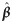
Latitude and longitude coefficients in the logit scale (β^ ±SD, 95% BCI) on logit occupancy (logit ψ^) of each bird species in the regional bird monitoring program in Argentina, 2003–2012.(a) Raptors; (b) ground omnivores and herbivores; (c) ground granivores; (d) other granivores; (e) insectivores mostly associated with folliage; (f) other insectivores. For details of species names and guilds, see S1 Table.